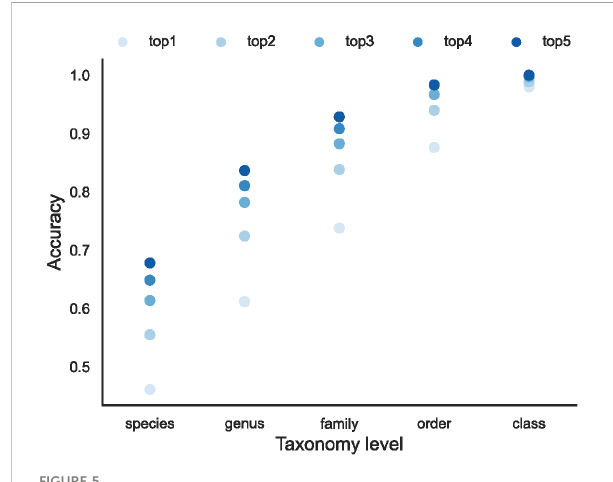
FIGURE 5 The top-n accuracy of EchoAI at different taxonomy levels.